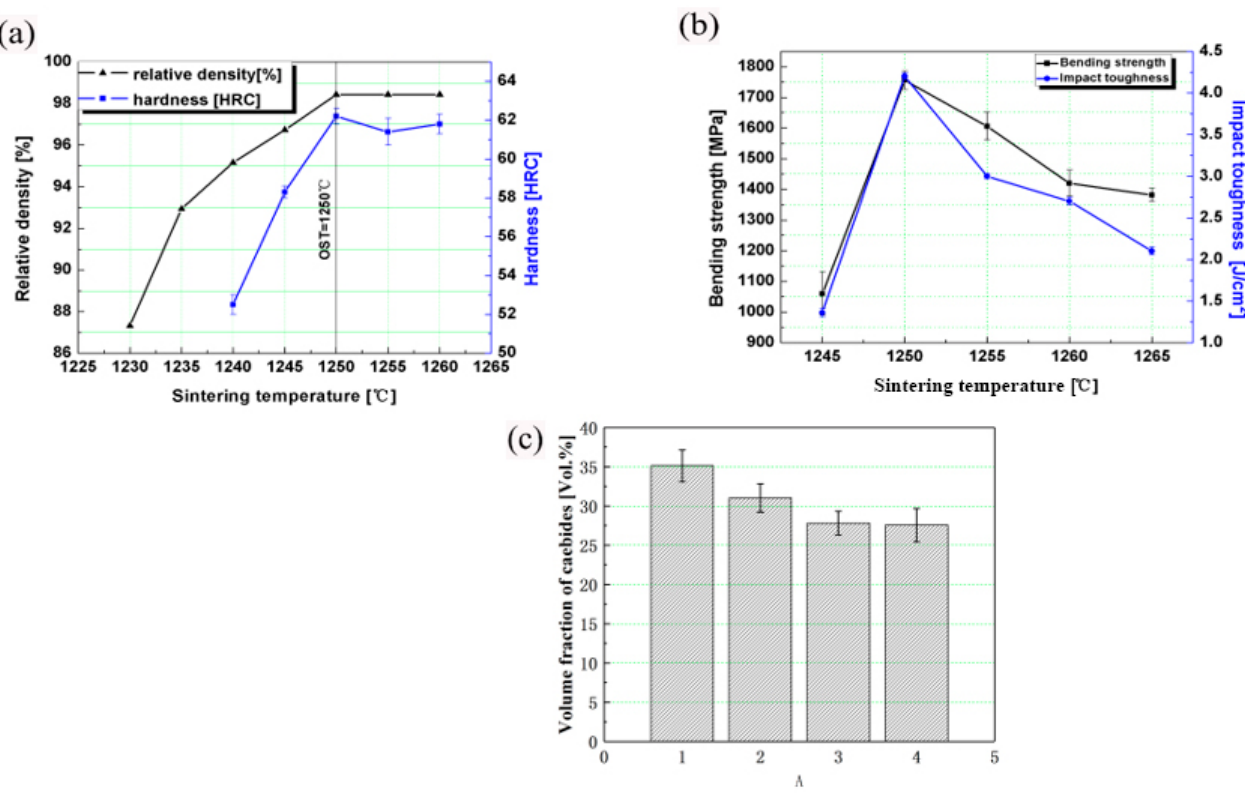
Figure 3. The effect of sintering temperature on ( a ) density and hardness, ( b ) bending strength and impact toughness, and ( c ) volume fraction of carbides.